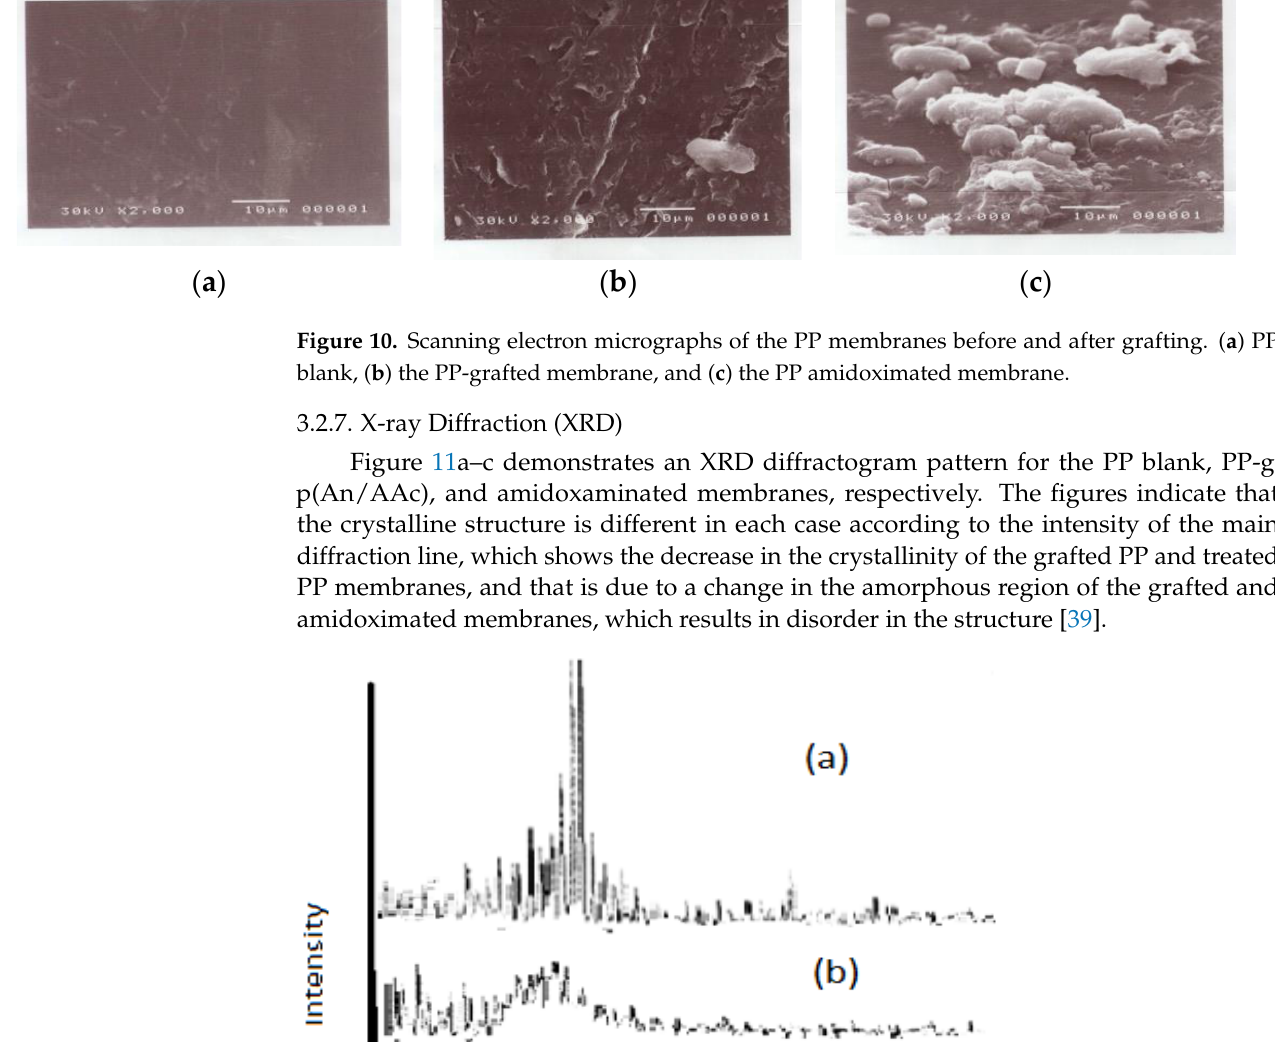
Figure 9. Differential scanning calorimeter diagram for the polypropylene samples. 1 — PP amidox- imated, 2 — PP-grafted, 3 — PP blank.